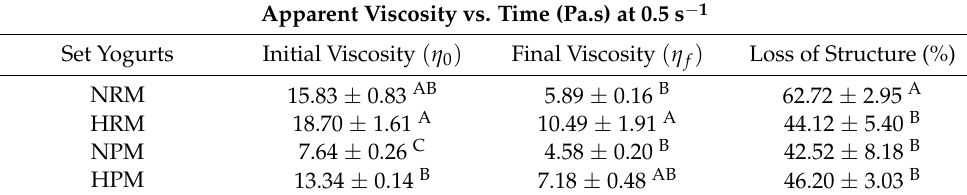
Figure 5. Influence of two-stage pressure homogenization on Lacprodan ® PL20 as it affects the apparent viscosity of set yogurts produced from raw milk and processed milk. Table 3. The initial and final apparent viscosities of set yogurts combined with enriched MFGM and their relationship with loss of structure after a two-stage pressure homogenization